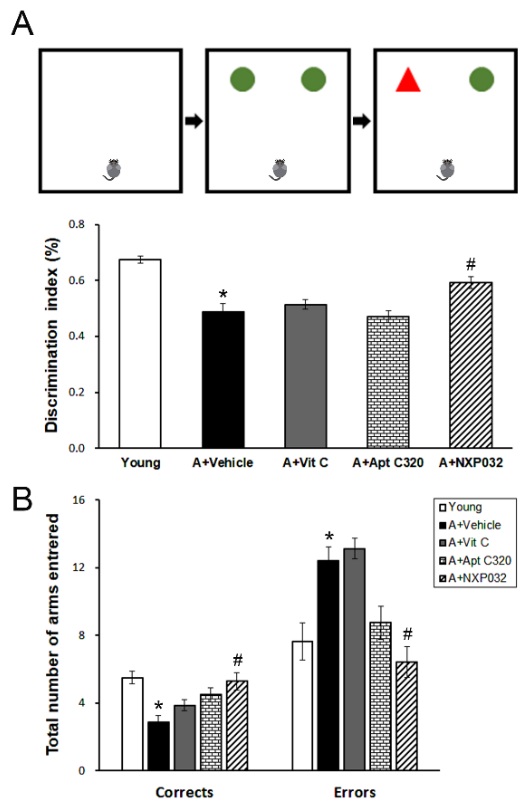
Figure 1. Effect of NXP032 on aging-induced cognitive impairment using the novel object recognition and radial 8-arm maze tests. ( A ) In the novel object recognition test, aged mice had significantly reduced discrimination index (%) compared to young mice. NXP032-treated mice show significantly improved discrimination index (%) compared to the vehicle-treated mice. ( B ) In the radial 8-arm maze test, aged mice had a significantly reduced number of correct choices and an increased number of error choices compared to young mice. NXP032-treated mice show a significantly improved number of correct choices compared to the vehicle-treated mice. NXP032-treated mice had a significantly lower number of error choices. The data are presented as the mean ± S.E.M. * p < 0.05, compared to the young group. # p < 0.05, compared to the aging (vehicle) group.